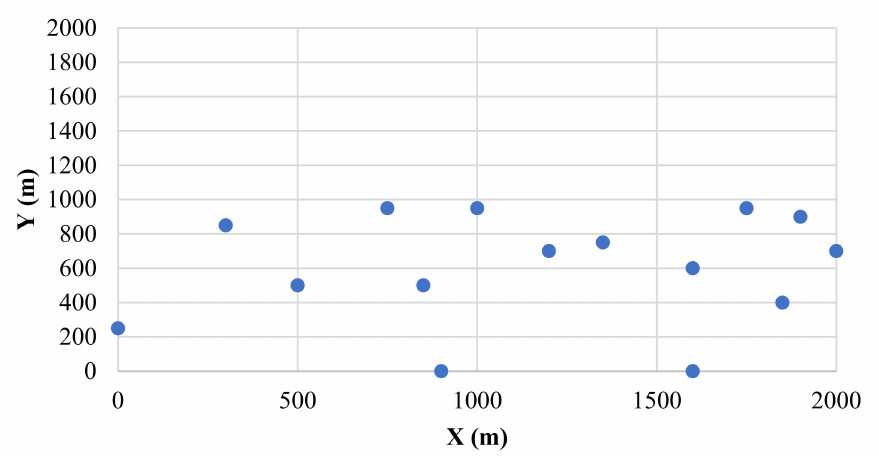
Figure 9. Position of turbines in Case